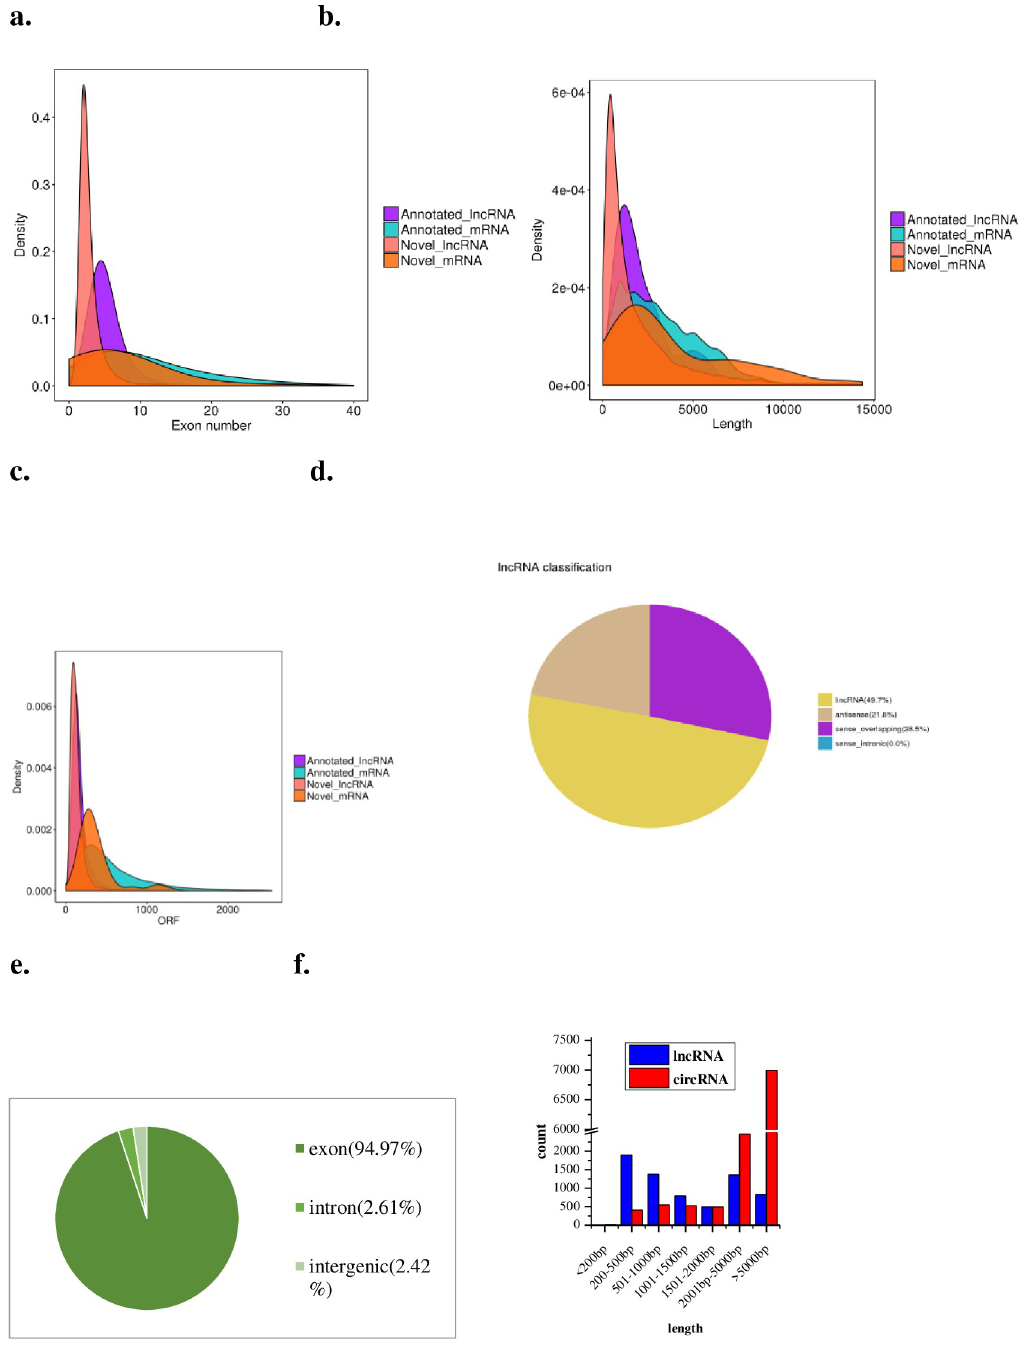
Fig 5. The features of lncRNAs and circRNAs during intramuscular preadipocyte differentiation. (a) Comparison of the numbers of exons in lncRNA and mRNA. (b) Comparison of the lengths of lncRNA and mRNA. (c) Comparison of the ORF sequence lengths of lncRNA and mRNA. (d) The types and proportions of novel lncRNAs. (e) The types and proportions of novel circRNAs. (f) The length distributions of lncRNAs and circRNAs.